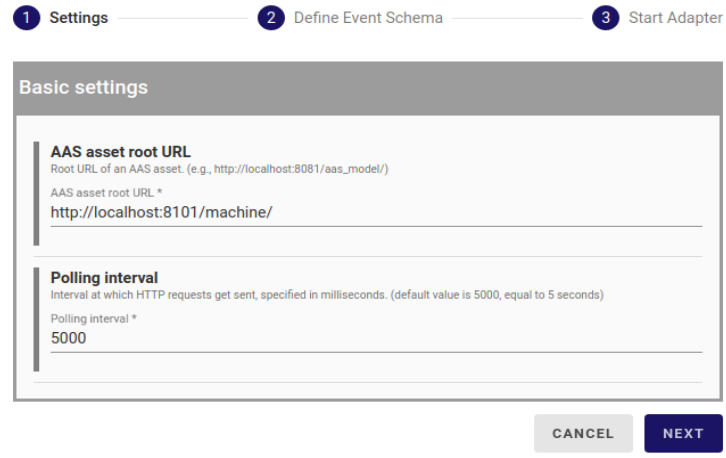
Figure 6. Configuration dialog when creating a DT Source.